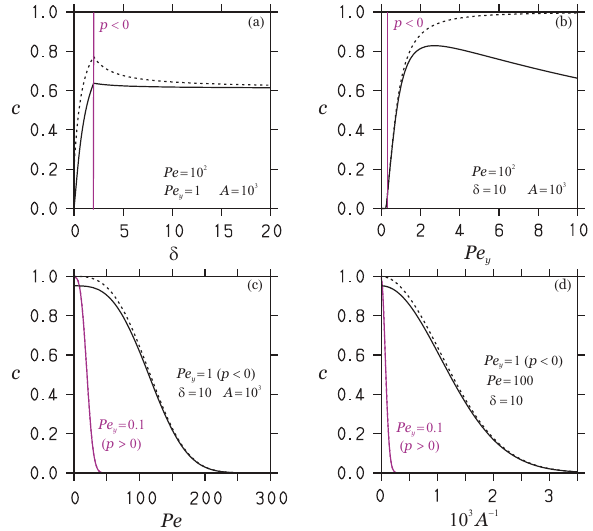
Figure 5. The concentration distribution at x ∗ = x 2 ∗ , y ∗ = y 1 ∗ (dashed lines) and y ∗ = y 2 ∗ (solid lines) for reference parameters δ = 10, Pe y = 1, Pe = 10 2 , and A = 10 3 . Variations of δ , Pe y , Pe , A are shown in ( a ), ( b ), ( c ), and ( d ), respectively. The reference parameters kept constant are also given. In ( a , b ), the vertical line separates p > 0 and p < 0 cases. In ( c , d ), both p > 0 and p < 0 cases are